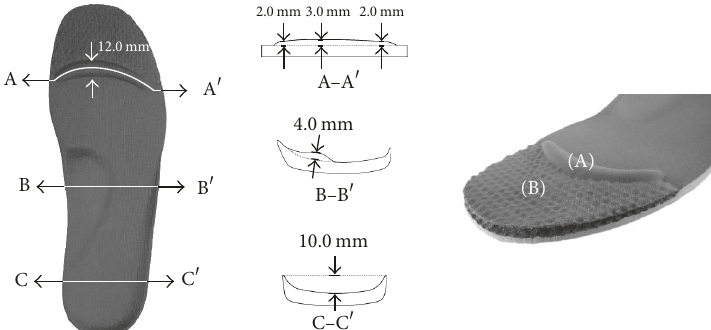
Figure 2: The insoles used in this study consisted of a toe-grip bar (A) and synthetic fiber with high repulsion properties